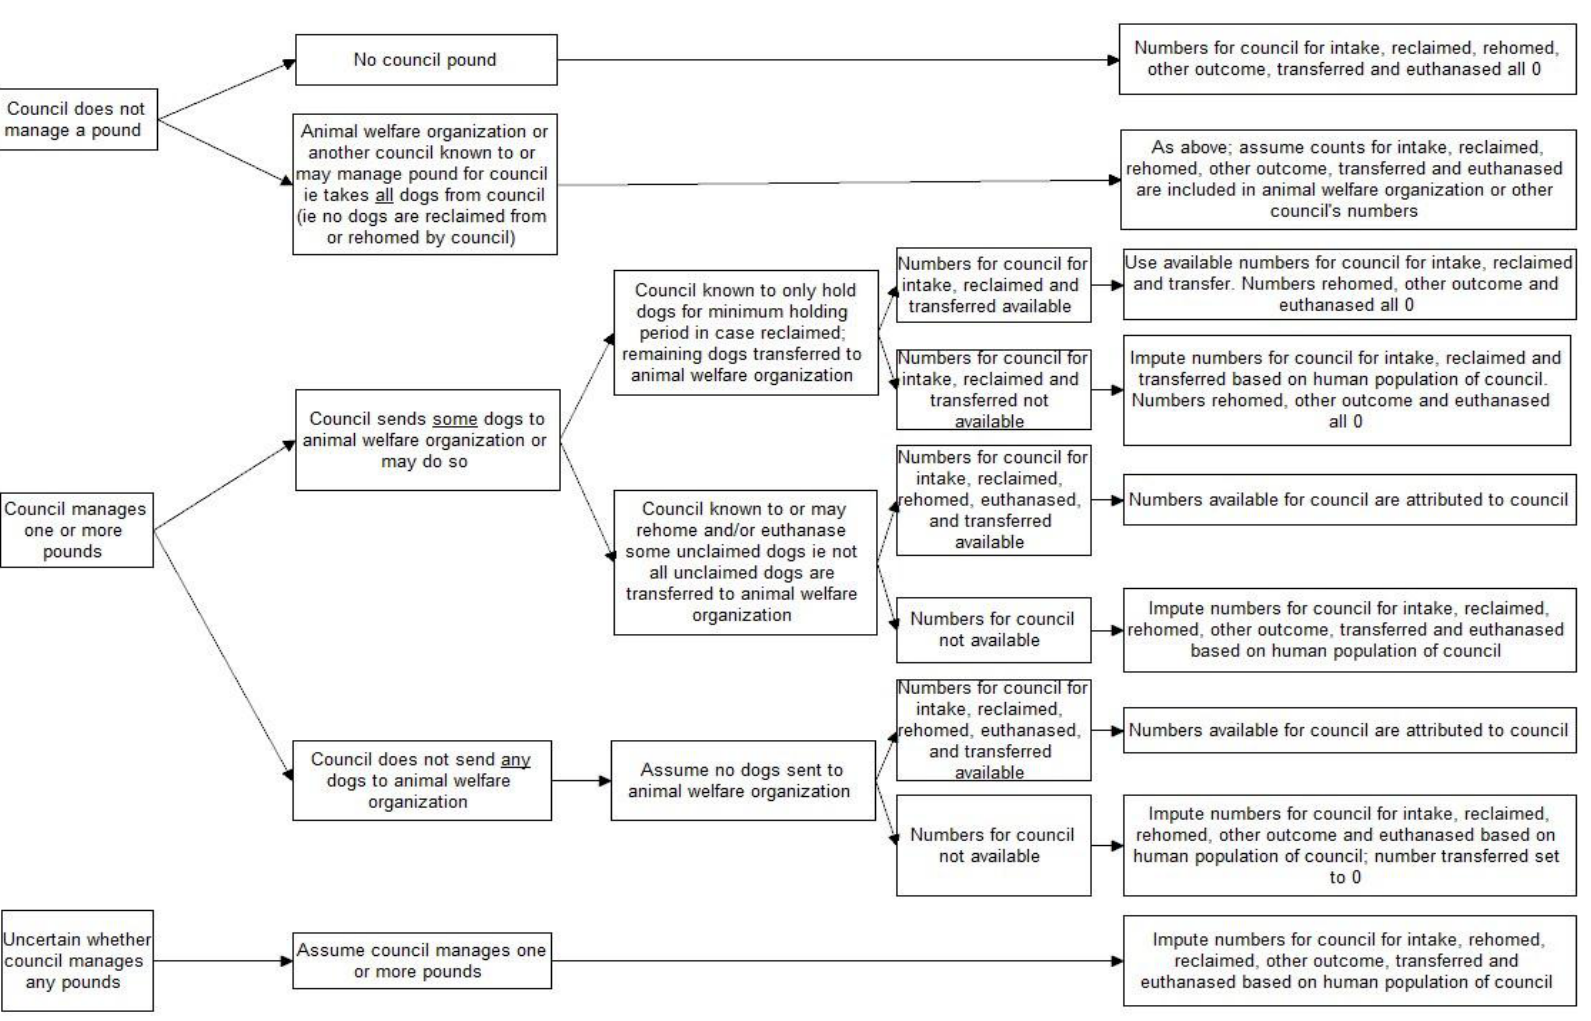
Figure A1. Algorithm of assumptions used to estimate numbers for municipal councils with incomplete or no data.